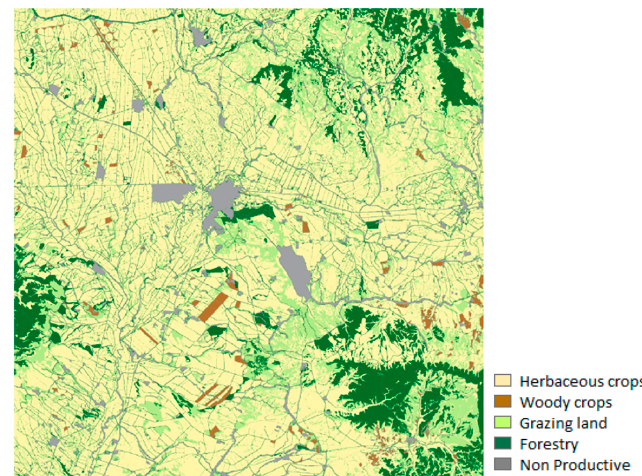
Figure 3. Land use classification in TS1 obtained from LPIS.